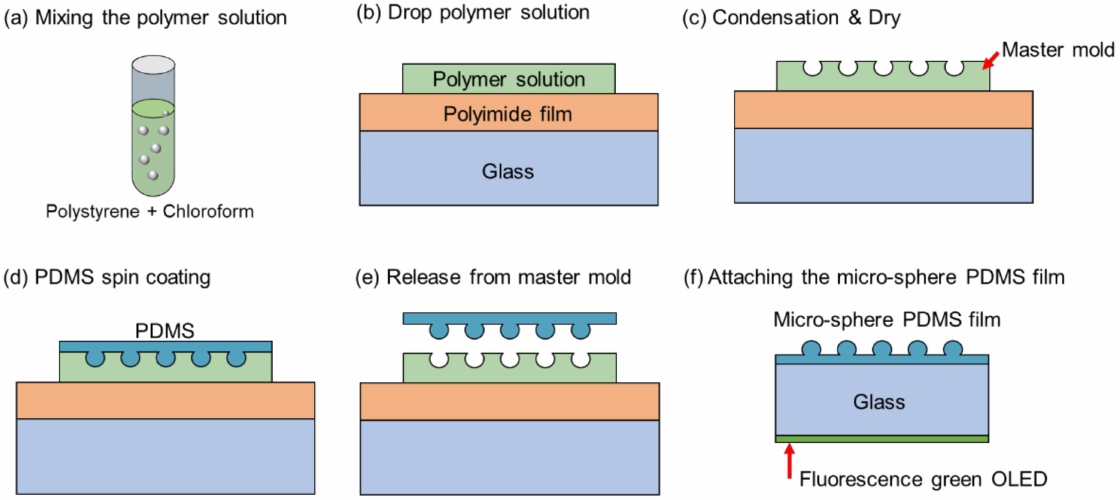
Figure 1. Schematic illustration of polymer mold and micro-sphere PDMS film fabrication process; ( a ) the polymer solution was produced by dissolving various forms of polystyrene (PS) in chloroform solution; ( b ) it was used as a carrier substrate by attaching polyimide tape to cleaned glass, and then 100 µ L of polymer solution was dropped onto the carrier substrate at 70% RH; ( c ) after solvent application, condensed air evaporated completely, and the master mold was completed; ( d ) the uncured PDMS was poured into the polymer mold and cured at 70 ◦ C on a hot plate for 2 h; ( e ) the micro-sphere PDMS film was released from the master mold; ( f ) the fabricated micro-sphere PDMS film was placed on the outside of the green OLED